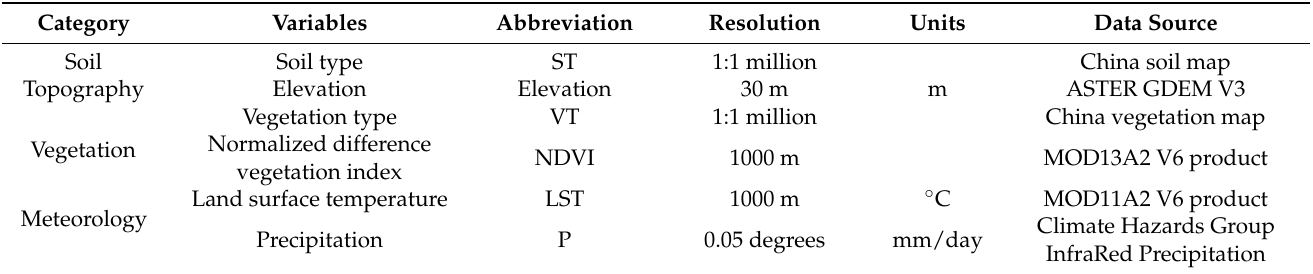
Table 1. Environmental variables for modeling the suitability of O. d. asiaticus